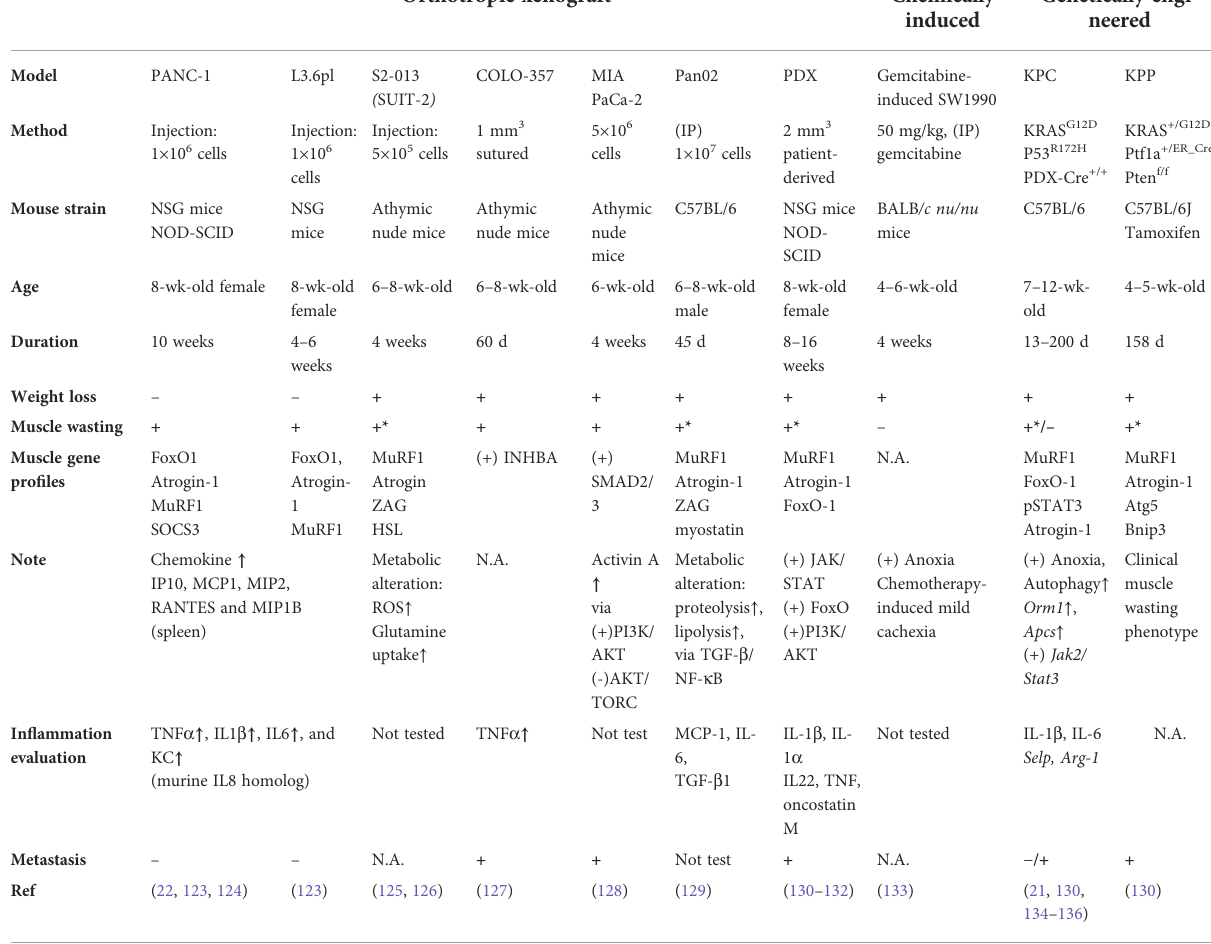
TABLE 4 Genetically engineered mouse models (GEMMs) of pancreatic cancer-derived cachexia